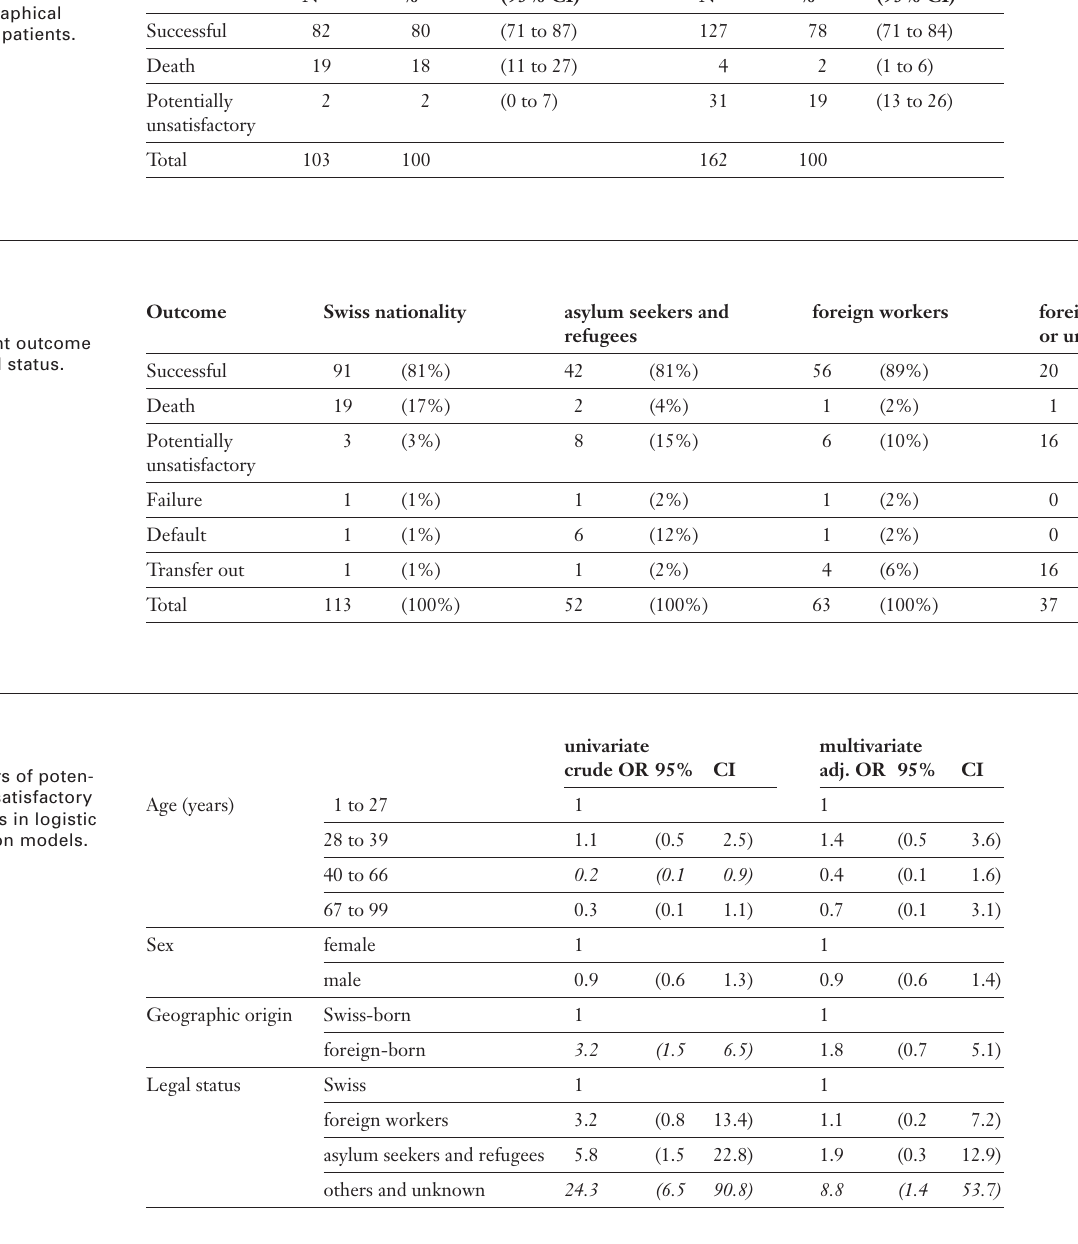
Treatment outcome by geographical origin of patients.